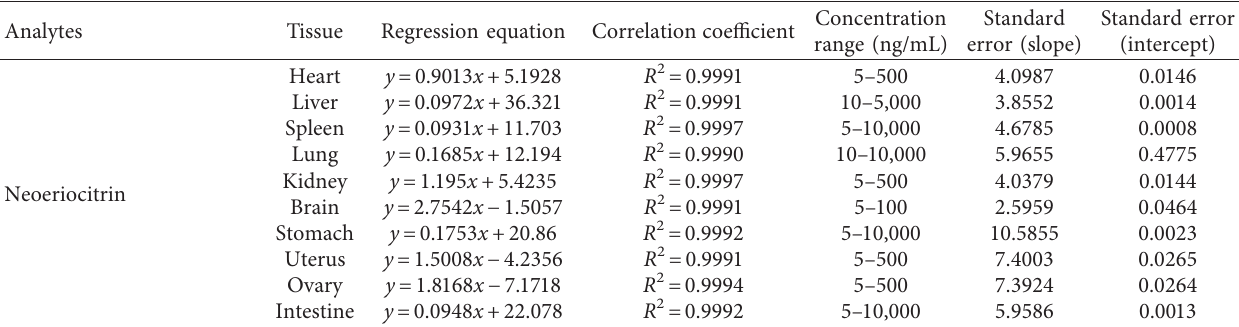
Figure 2: Representative MRM chromatograms of seven analytes and quercetin (IS): (a) blank liver homogenates; (b) blank liver ho- mogenates spiked with the seven analytes and IS; and (c) liver homogenates 1h after oral administration of TFDR (4g/kg; mean ± SD; n � 6). Table 2: The linear equations and range of seven analytes in different rats’